Question: Describe this figure in one sentence.
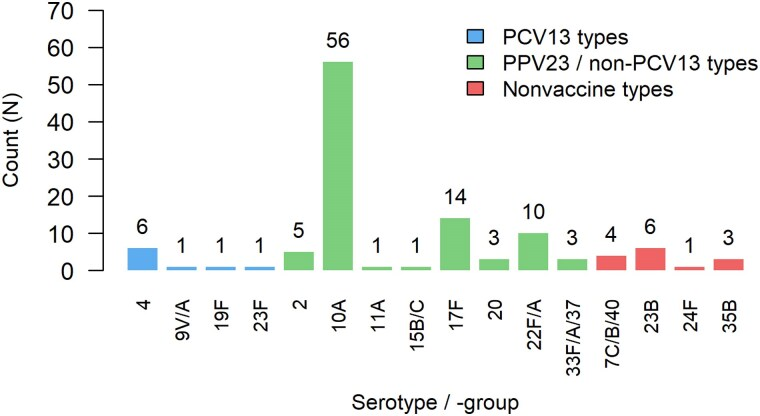
Answer: Distribution of serogroups/types of pneumococci in samples from 1764 adults 65 y or older in Denmark, 2019–2022.